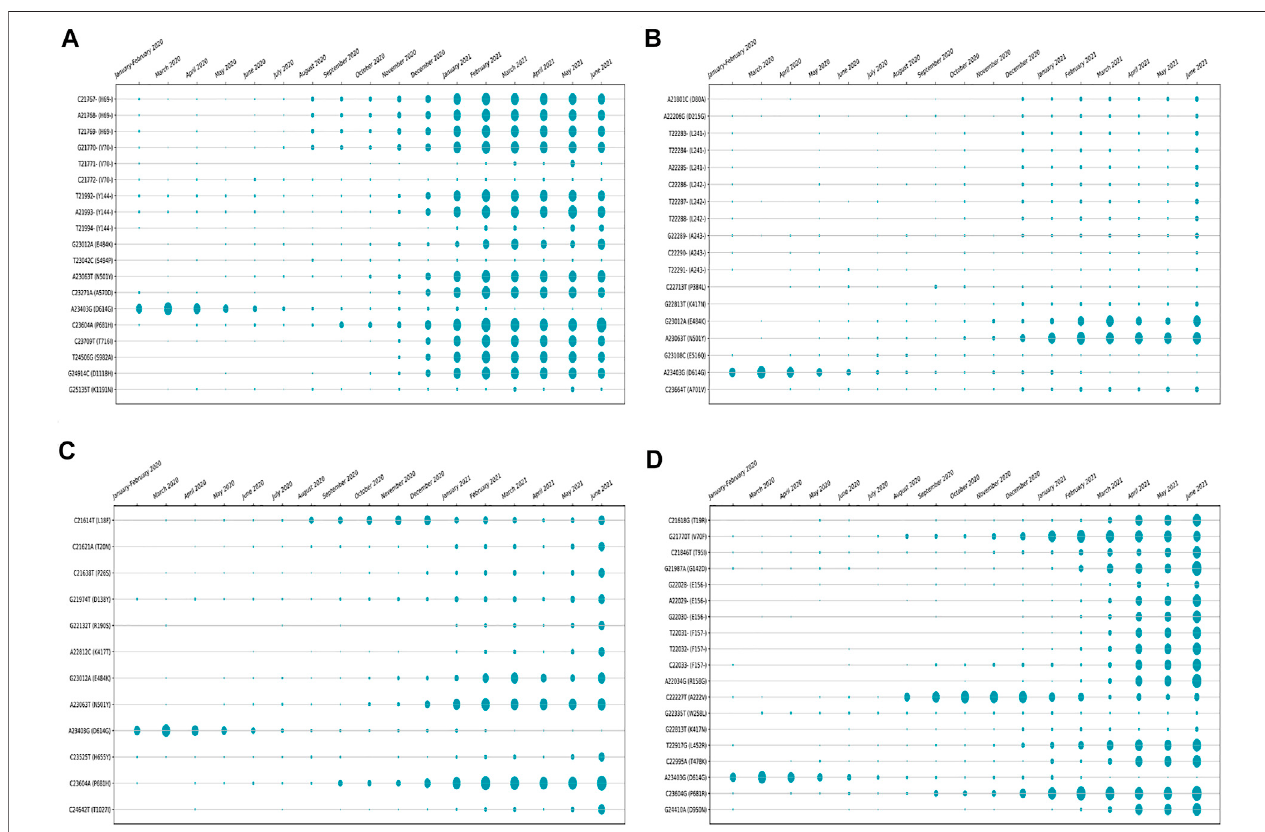
FIGURE 7 | Month-wise evolution of (A) Alpha (B.1.1.7), (B) Beta (B.1.351), (C) Gamma (501.V3), and (D) Delta (B.1.617.2) variants in global SARS-CoV-2 genomes.